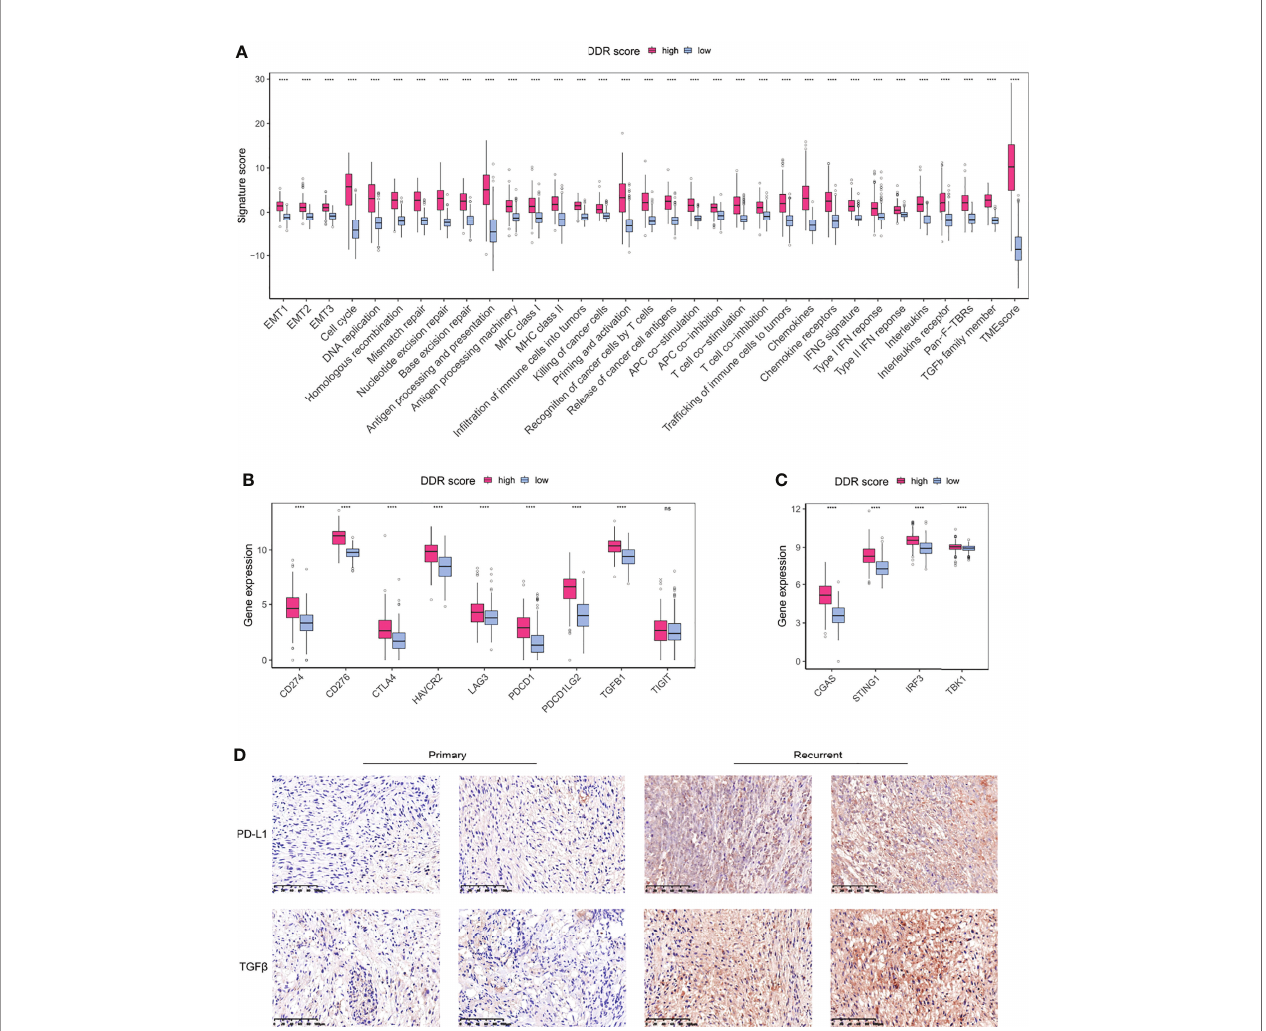
FIGURE 6 | DDR-associated immune microenvironment signatures and characteristics. (A) The differentially expressed TME signatures in high and low DDR score groups. (B) The expression levels of immune checkpoints in high and low DDR score groups. (C) The expression levels of cGAS-STING pathway members in high and low DDR score groups. (D) IHC staining of PD-L1 and TGF b in primary and recurrent glioma tissues (20×magni fi cation). EMT, epithelial-to-mesenchymal transition; MHC, major histocompatibility complex; HLA, human leukocyte antigen; IFN, interferon; Pan-F-TBR, pan- fi broblast TGF b response. ****p <